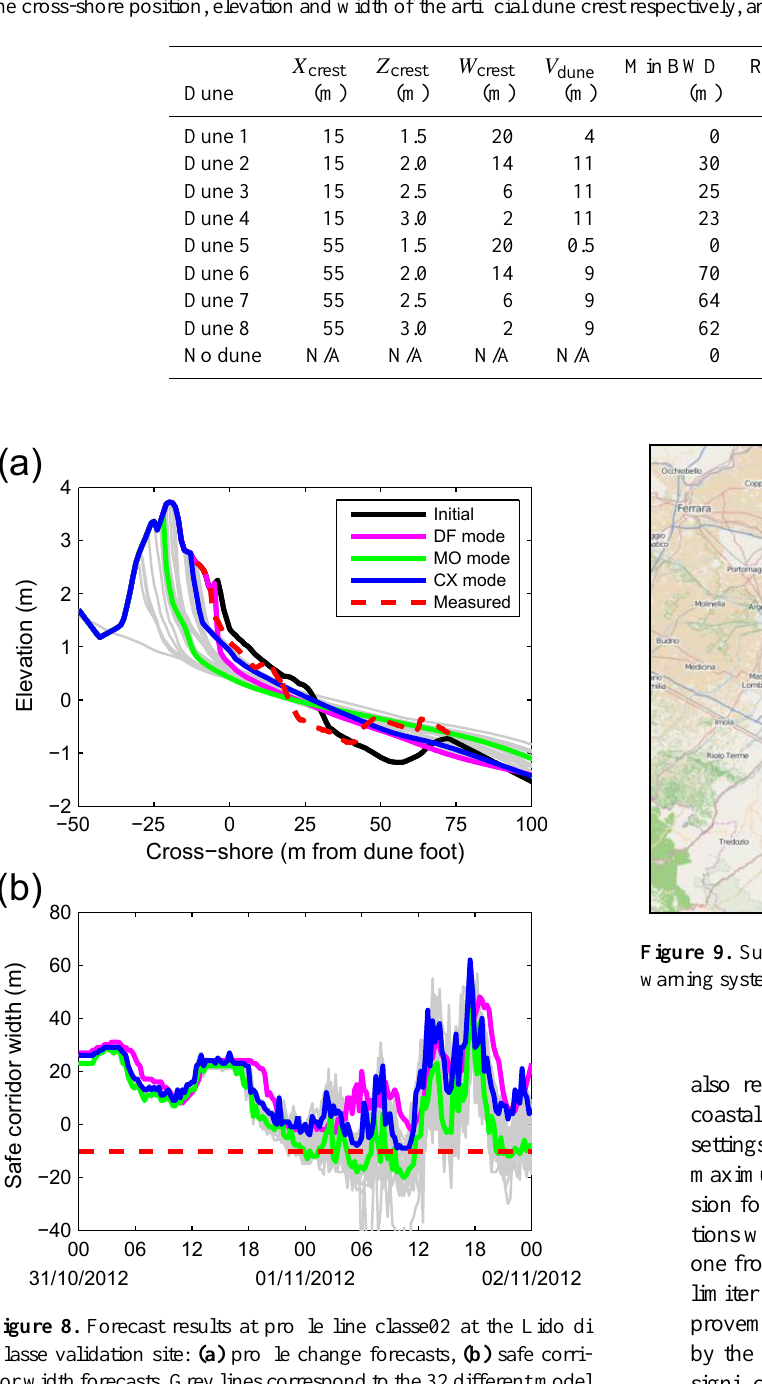
Table 3. Results of the eight different dune configurations tested at Rimini for the what-if scenario analysis. X crest , Z crest and W crest refer to the cross-shore position, elevation and width of the artificial dune crest respectively, and V dune is the dune volume per alongshore metre.